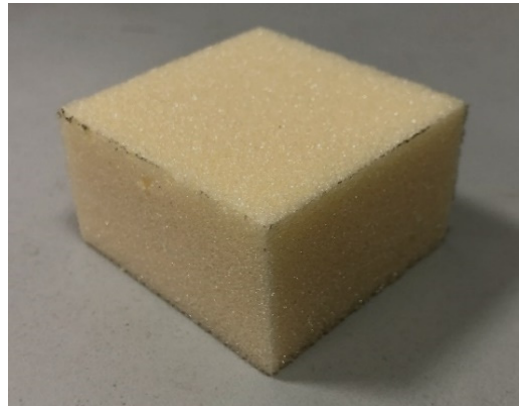
Figure 1. the polyvinyl chloride (PVC) foam used in this study. Figure 1. The polyvinyl chloride (PVC) foam used in this